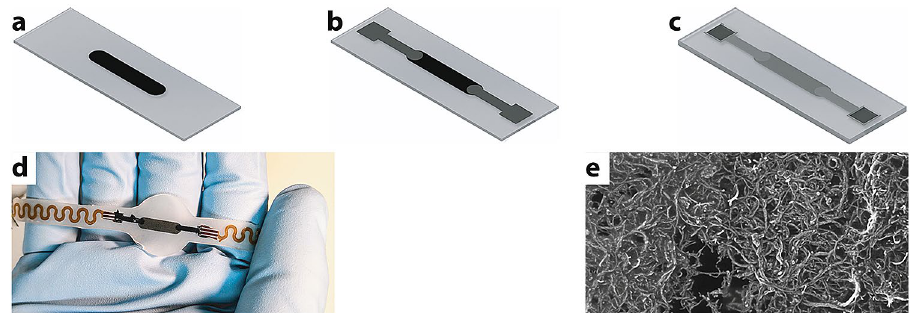
Figure 6. Fabrication. ( a ) PDMS plus Triton X, with deposited MWCNT film. ( b ) Conductive polymer patterned electrode. ( c ) Encapsulation. ( d ) Interconnection with printed circuits. ( e ) Scanning Electron Microscopy image of MWCNT film (Scan time 50 µ s , 7.5 µ m